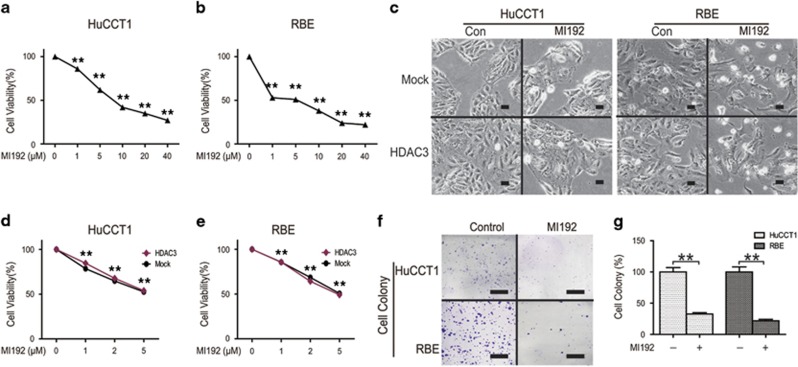
The inhibitory effect of MI192 on CCA cell viability. (a and b) Cells were treated with MI192 and quantified via CCK8 assay. (c) Cells were treated with MI192 and morphological changes were observed. The magnification is x200. Scale bars, 100 μm. (d and e) Cells were transfected with HDAC3 overexpression vector, and then treated with MI192 and quantified via CCK8 assay. (f and g) Cells were treated with MI192. Colonies were stained with crystal violet (left) and quantified (right). Scale bars, 1 cm; **P<0.01